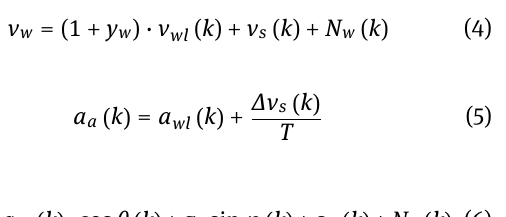
Figure 3: Software functional module structure